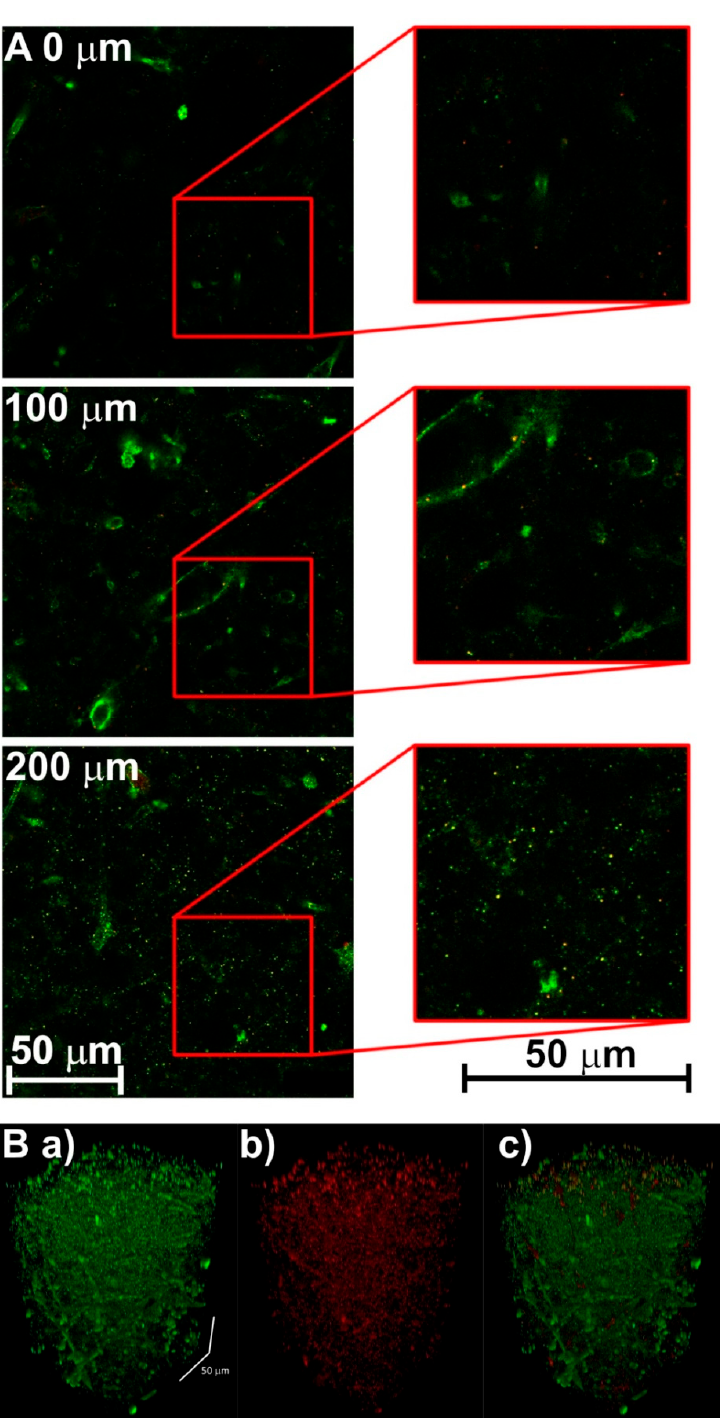
Figure 6. Images of the human nucleus accumbens created by one-photon confocal laser scanning microscope Leica TCS SP8 X after hydrogel-forming and staining; experimental conditions in 2.5 Brain tissue staining and confocal microscopy. Histological sections at different depths of 0, 100, and 200 µ m of human nucleus accumbens after immunohistological staining ( A ). Parvalbumin positive fibers of gamma-aminobutyric acid (GABA) neurons appear green and tyrosine hydroxylase stained dopamine neurons appear red. 3-D reconstruction of brain tissue ( B ) performed to a depth of 230 μ m with a depiction of the bodies of individual neurons: ( a ) GABA neurons, ( b ) dopamine neurons, ( c ) both types of neurons together.